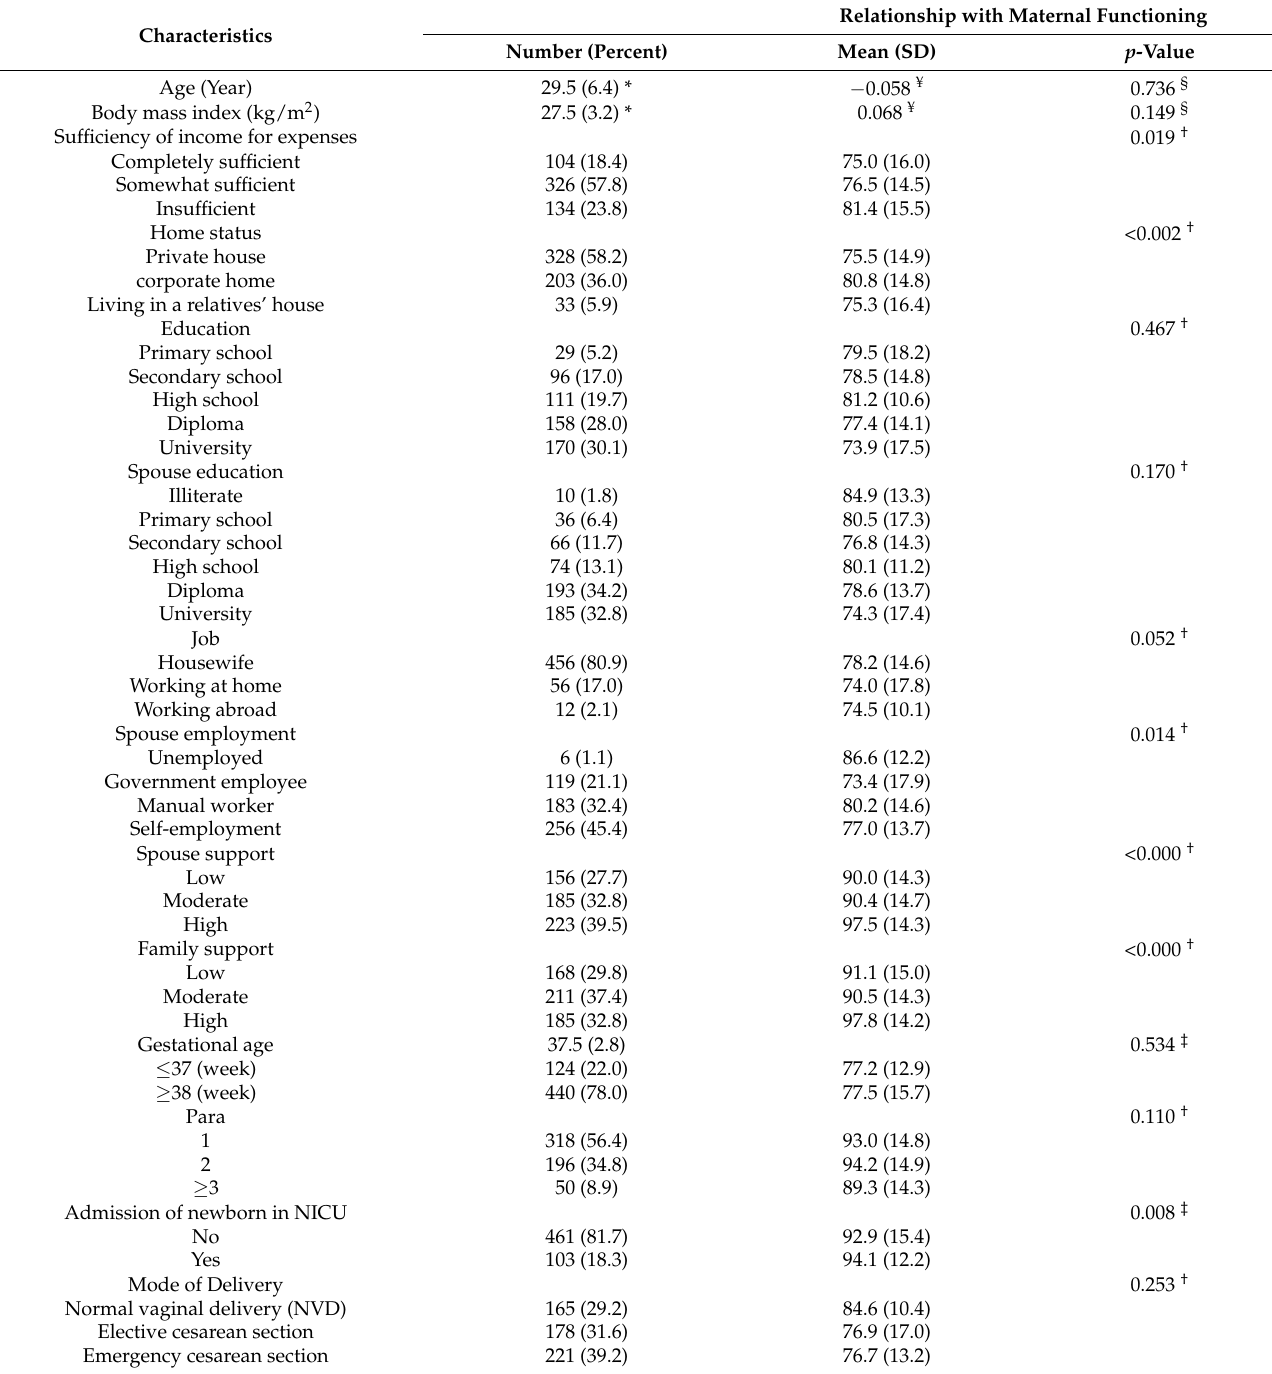
Table 1. Sociodemographic and obstetric characteristics of the participants ( n =